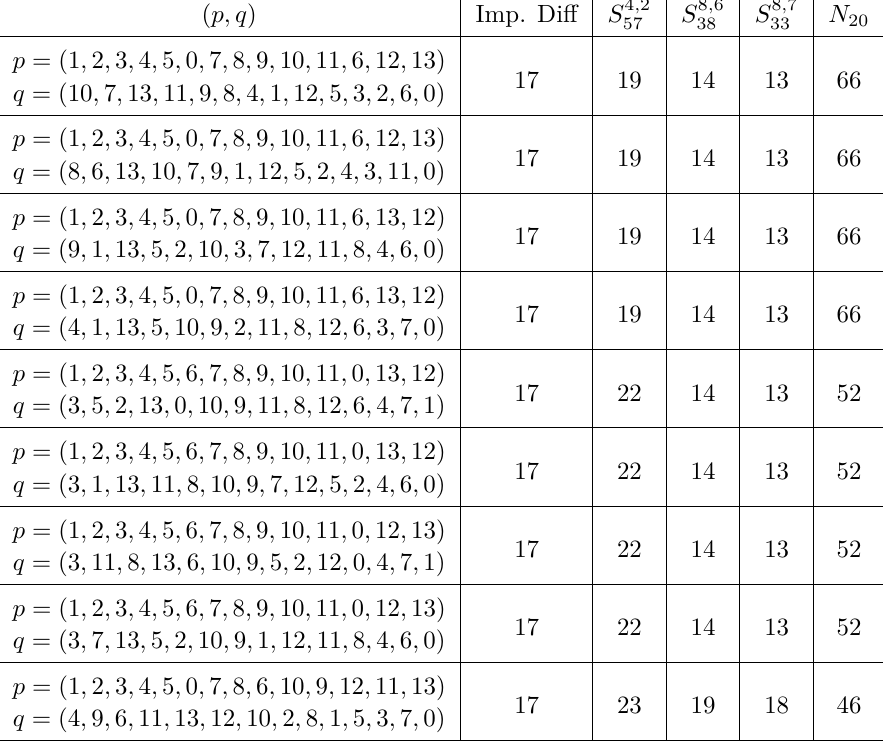
Table 4: Security evaluation for the best equivalence classes with k = 14 ( p, q ) Imp. Diff S 4 , 2